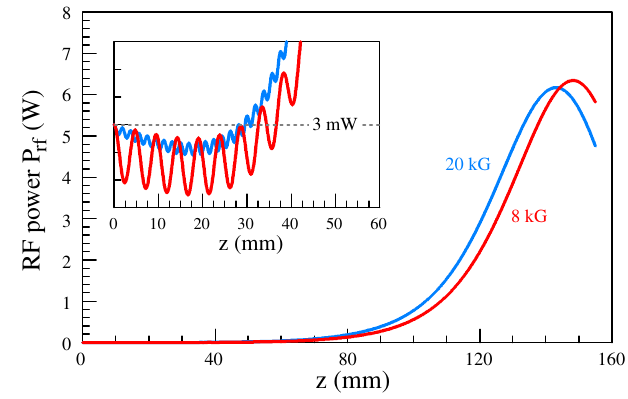
FIG. 15. (Color) Dependence of rf power P on axial distance z rf for 8-kG and 20-kG focusing magnetic fields. The input rf power is 3 mW at 220 GHz. The injected 30.2-keV, 25-mA beam has an axial velocity spread of (cid:2) (cid:1) (cid:3) 7 : 5 (cid:10) 10 (cid:4) 4 . The rf power fluctu- ations for the beam focused by a 20-kG magnetic field are much smaller in the initial low power